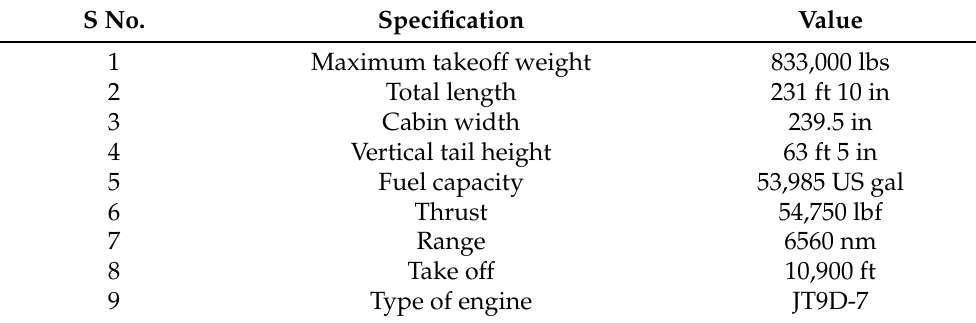
Table 1. General specifications of the BOEING 747-200 aircraft